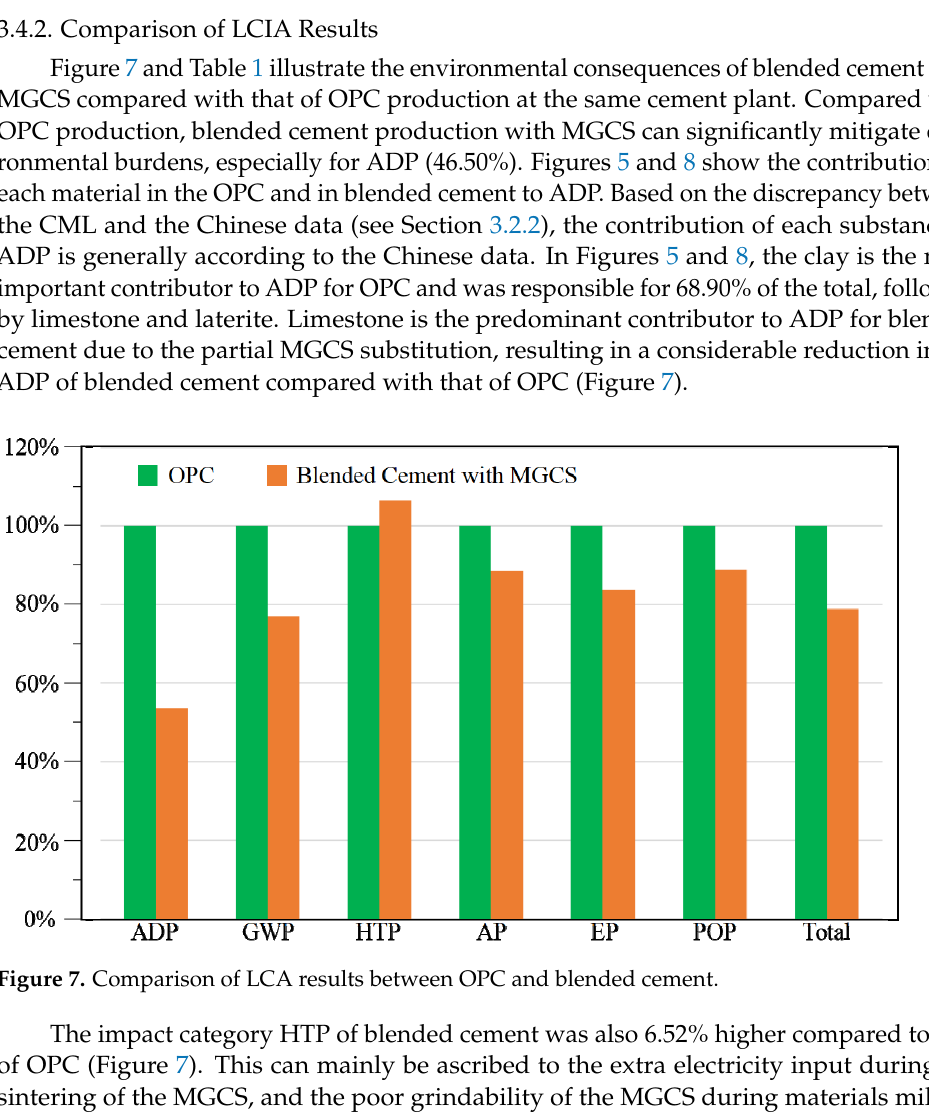
Figure 8. Environmental impacts to ADP of each substance in OPC with Chinese data.